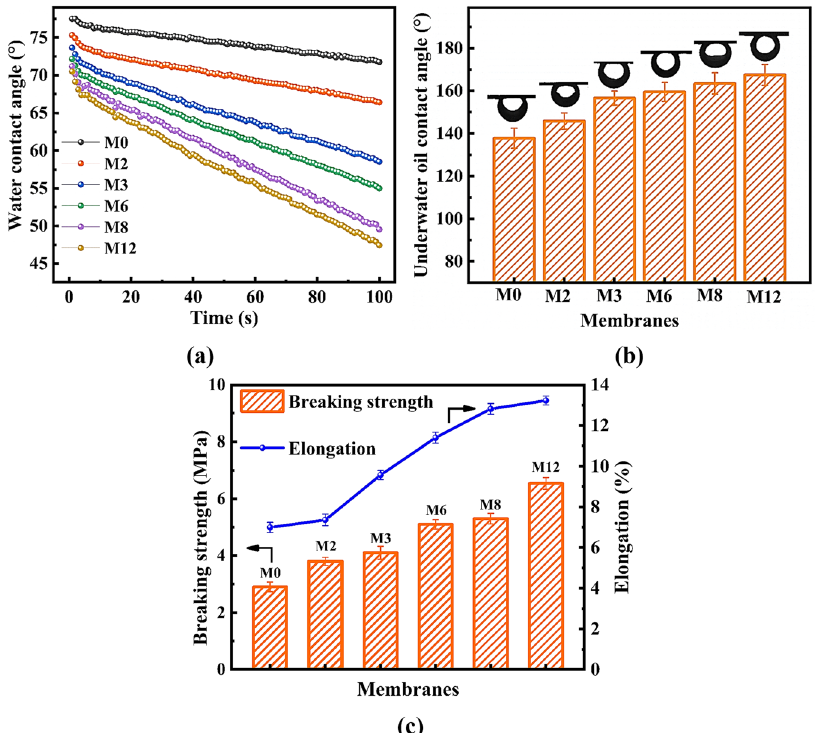
Fig. 7 Hydrophilicity and structure characterizations. The Air − Water stability dynamic water contact angle of the blend membranes ( a ) and oil − Water Contact Angles ( b ). The Mechanical strength of the PSF/EVOH membrane and MMMs ( c ). The error bars display the data ’ s standard deviation from three independent